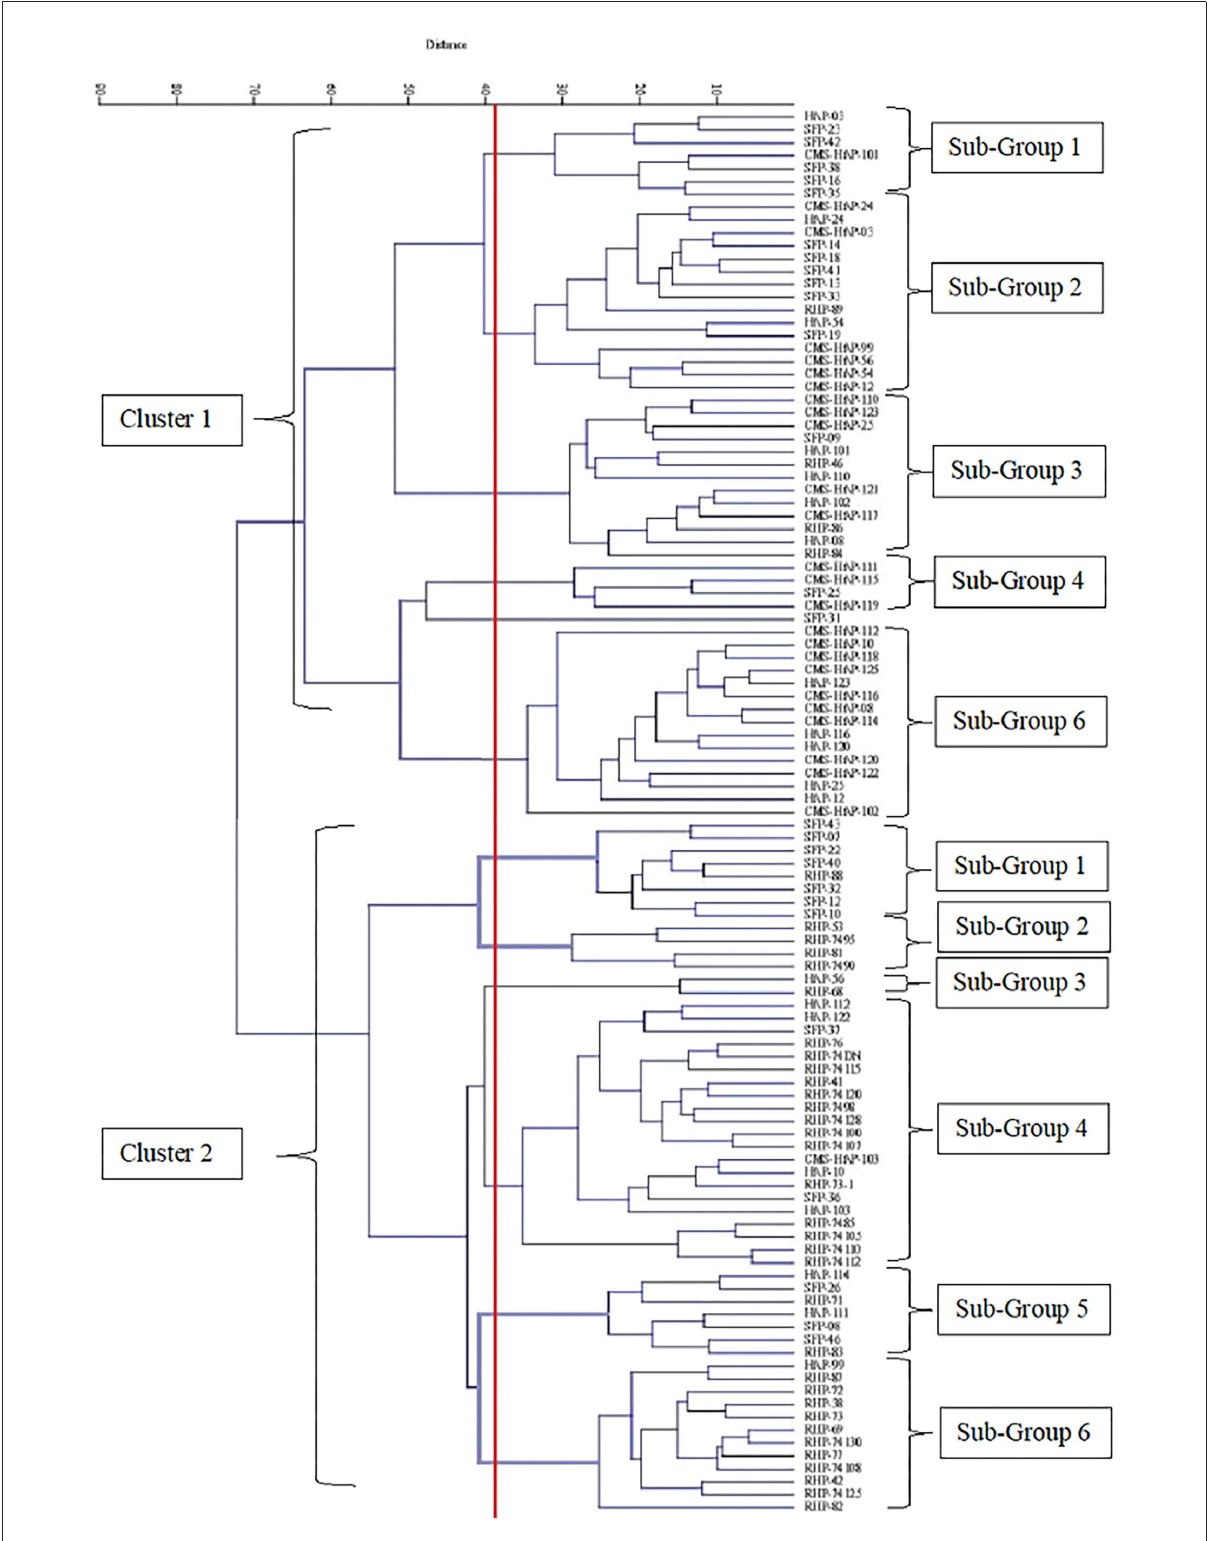
FIGURE1 Cluster diagram constructed on nine morphological data of 109 sunflower